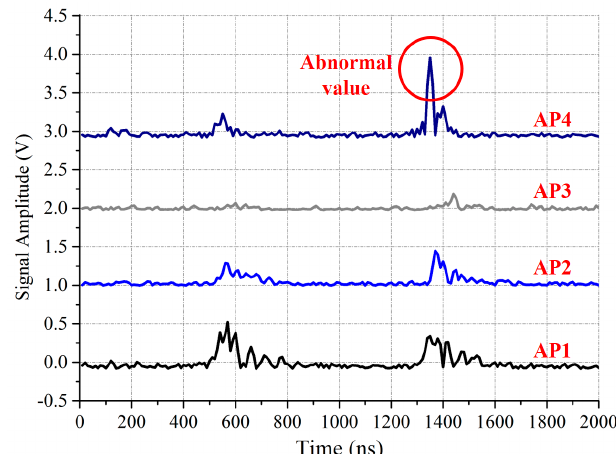
Figure 5. The digital envelope detection waveforms, which show the abnormal RSSI values phenomenon in the offline stage.